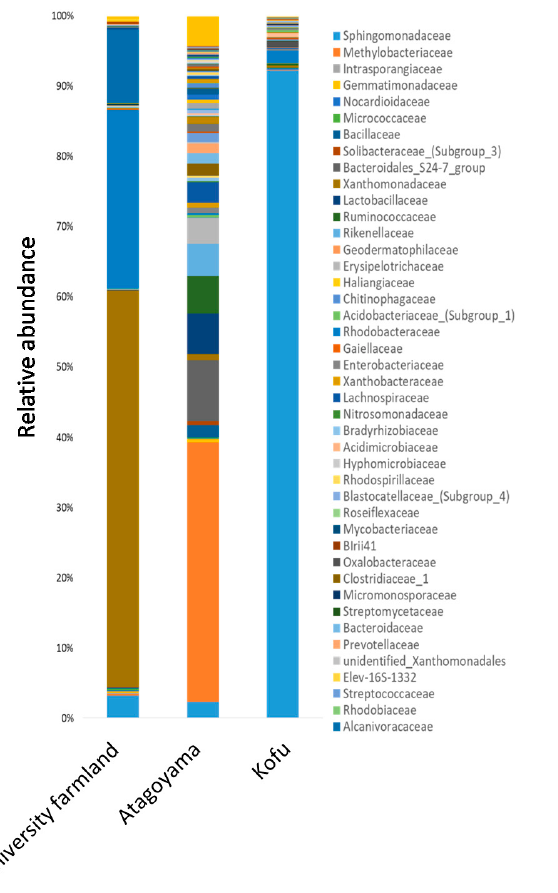
Figure 3. Relative abundance (based on total sequence reads) of endophytic bacterial families in microbiomes of ice plants grown in three different soils in a pot experiment.